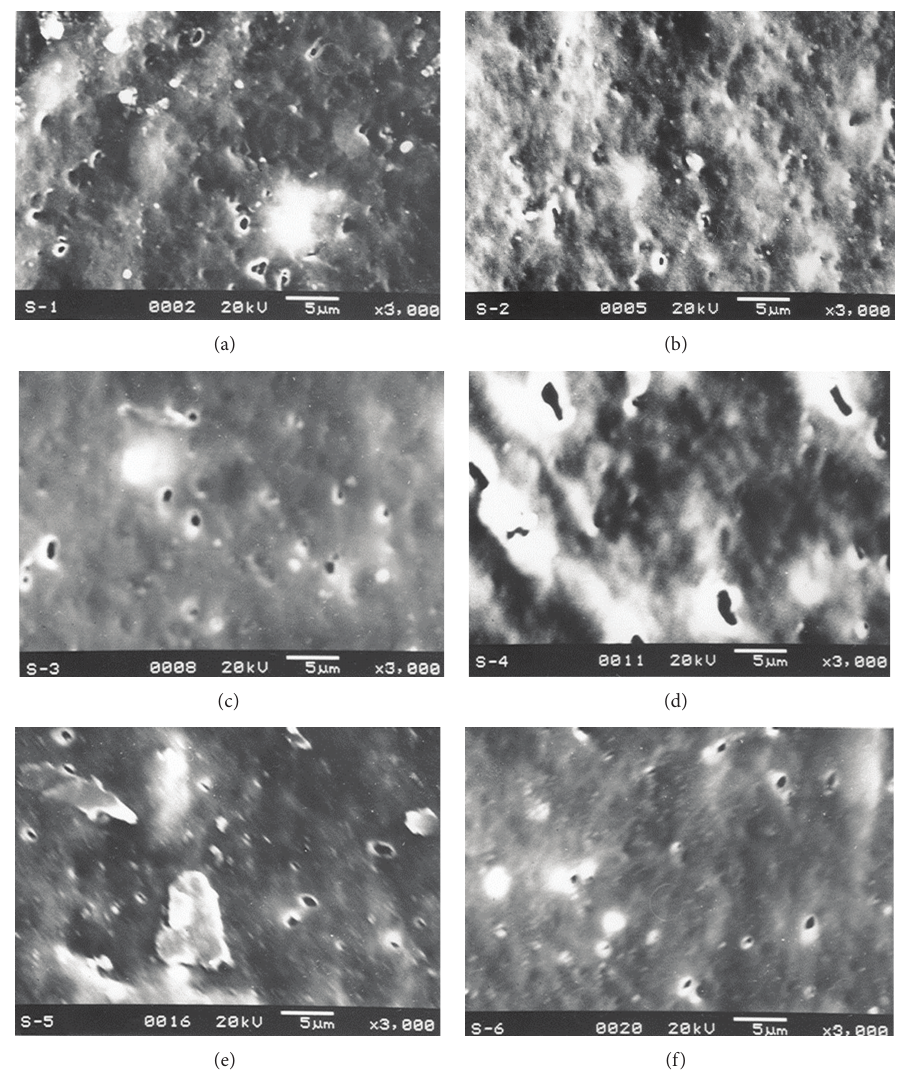
Figure 2: Scanning electron micrographs showing the various stages of experiments for optimization of microporosity on the surface of compatibilized